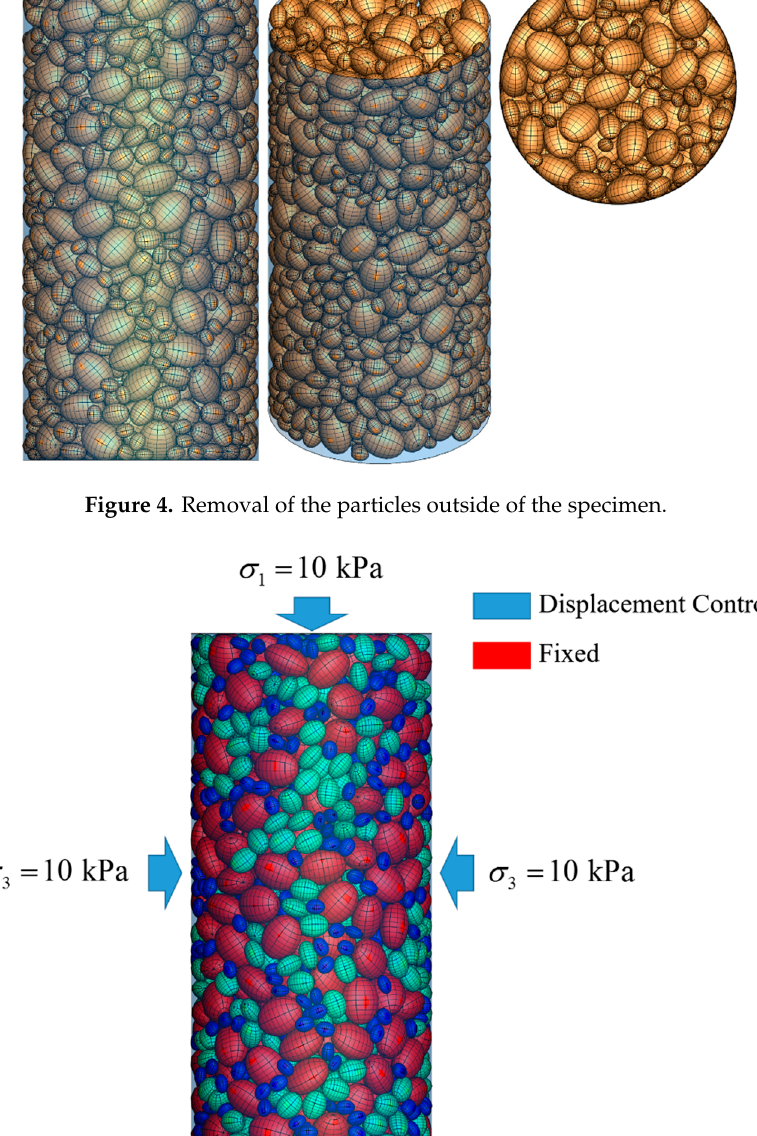
Figure 4. The cobble sample after deposition.